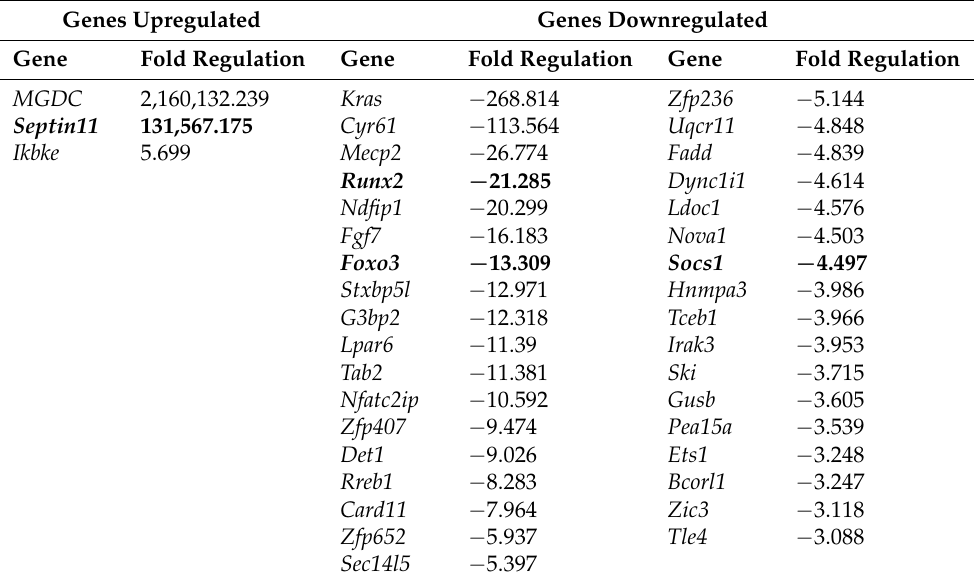
Table 4. Expression of miR-155 target genes in cortical samples from 9-month-old 3xTg-AD mice vs. respective wild-type (WT)